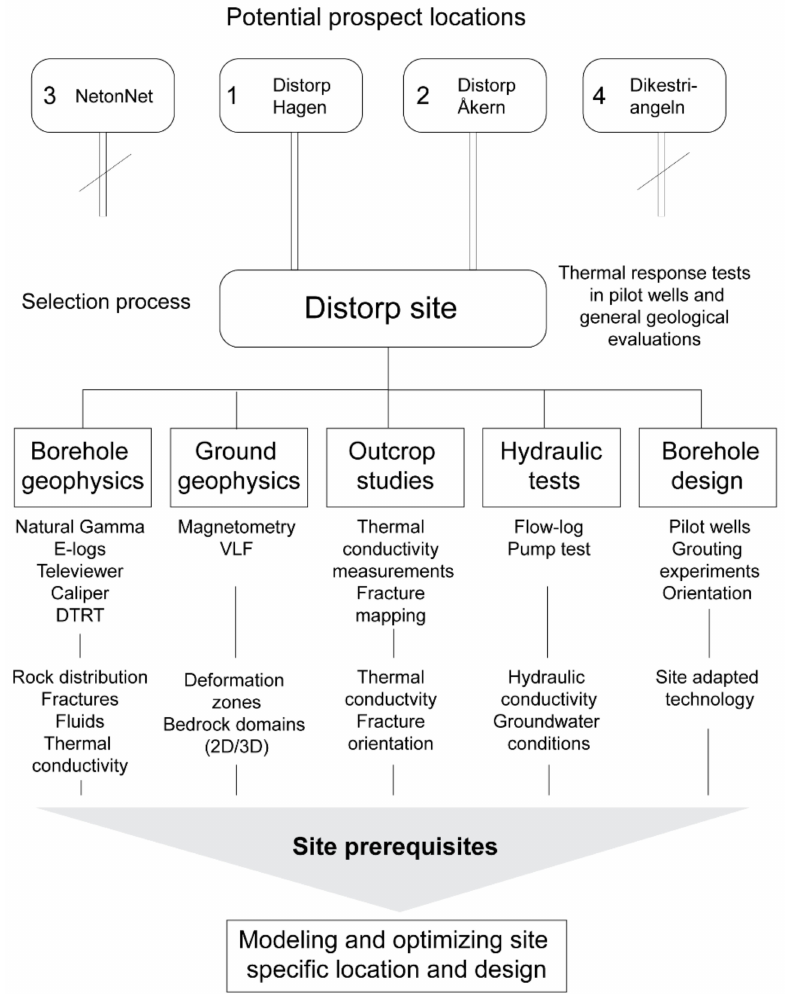
Figure 2. Diagram illustrating the various aspects of the site investigation, as well as the methodolo- gies used. The parameters obtained from the various investigations, used as input to the modeling and site assessment are also shown. The different prospect locations are shown in Figure